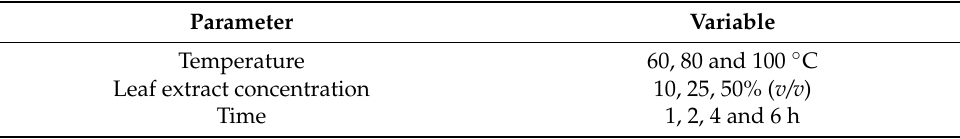
Table 1. The optimized rGO synthesis parameter